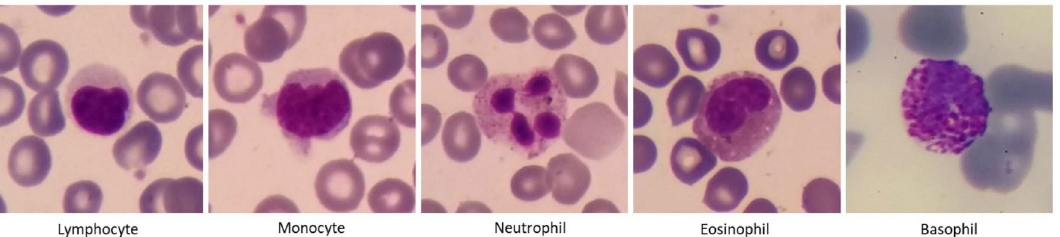
Figure 1. Five types of white blood cells in the normal peripheral blood.